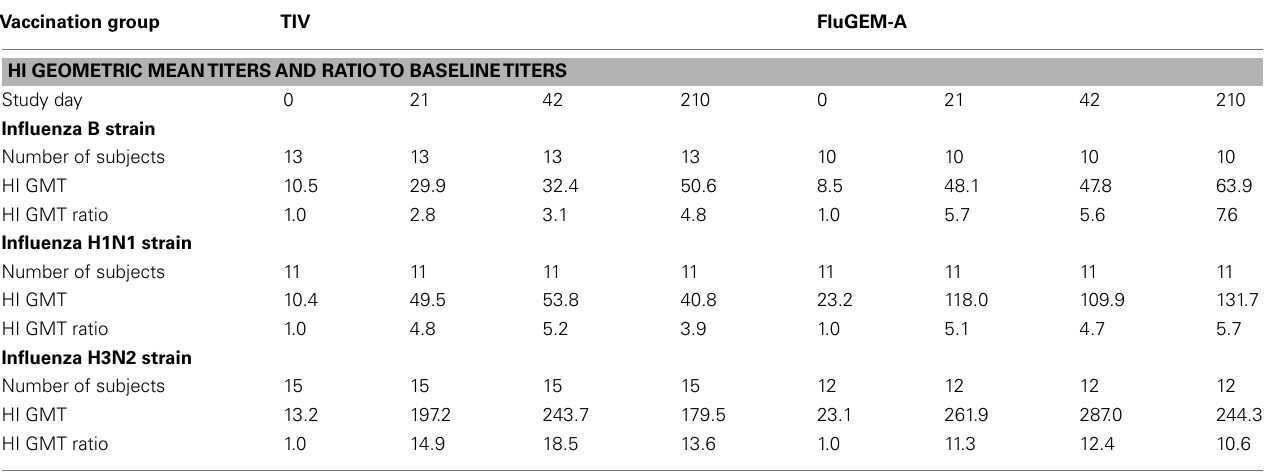
Table 4 | HI titers specific for all three influenza strains included in the vaccine. Vaccination